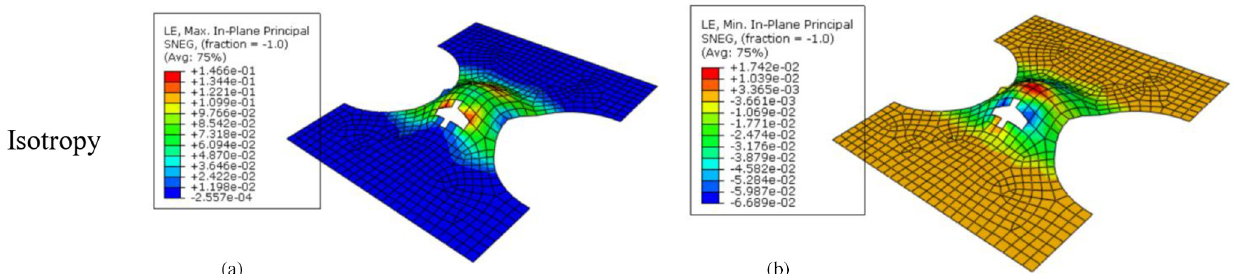
Fig. 14. (a) Maximum in-plane principle strain under plane stretching. (b) Minimum in-plane principle strain under plane stretching.